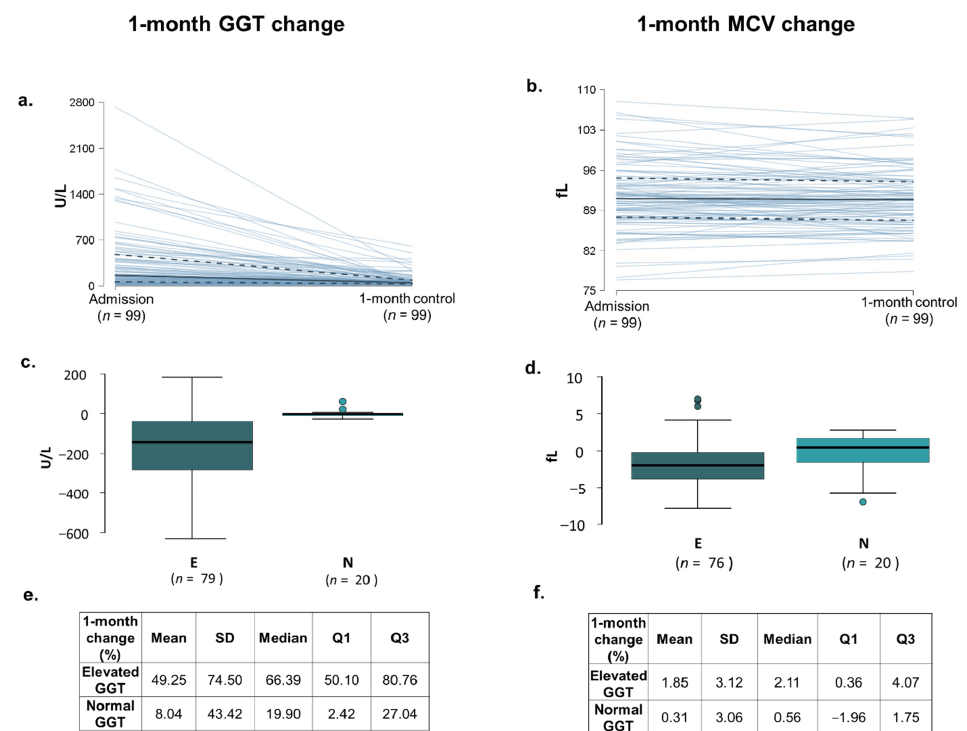
Figure 2. Analysis of the change in GGT and MCV levels. Figures show the change in laboratory values between discharge and the 1-month control visit. ( a , b ) Line chart; median ——— Q1; 3; ( c , d ) change in absolute value; ( e , f ) change in percent value. Note: in the group of patients with elevated (E) admission GGT level, discharge and 1-month values, and admission and 1-month values in the group of patients with non-elevated (N) admission GGT level, were included in the analysis. fL— femtoliter; U/L—unit/liter; E: patients with elevated admission GGT; N: patients with non-elevated admission GGT.